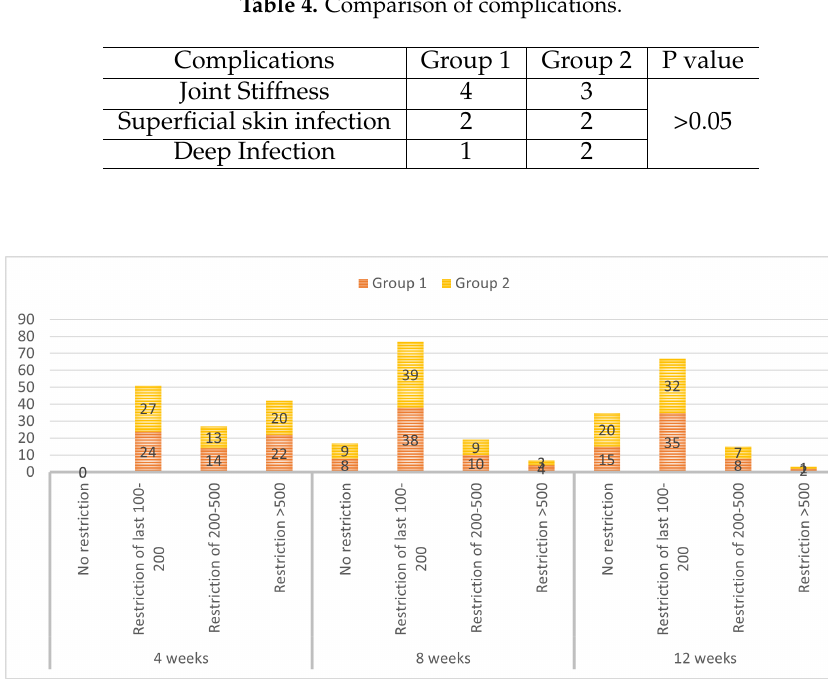
Table 4. Comparison of complications.